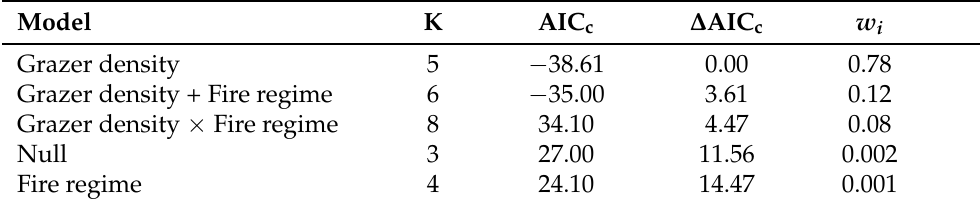
Table A1. Generalized linear models explaining the effects of fire regime and grazer density on temporal variability of standing crop, Grand River Grasslands, southern Iowa, USA. Table includes the number of parameters included in the model (K), Akaike’s information criterion adjusted